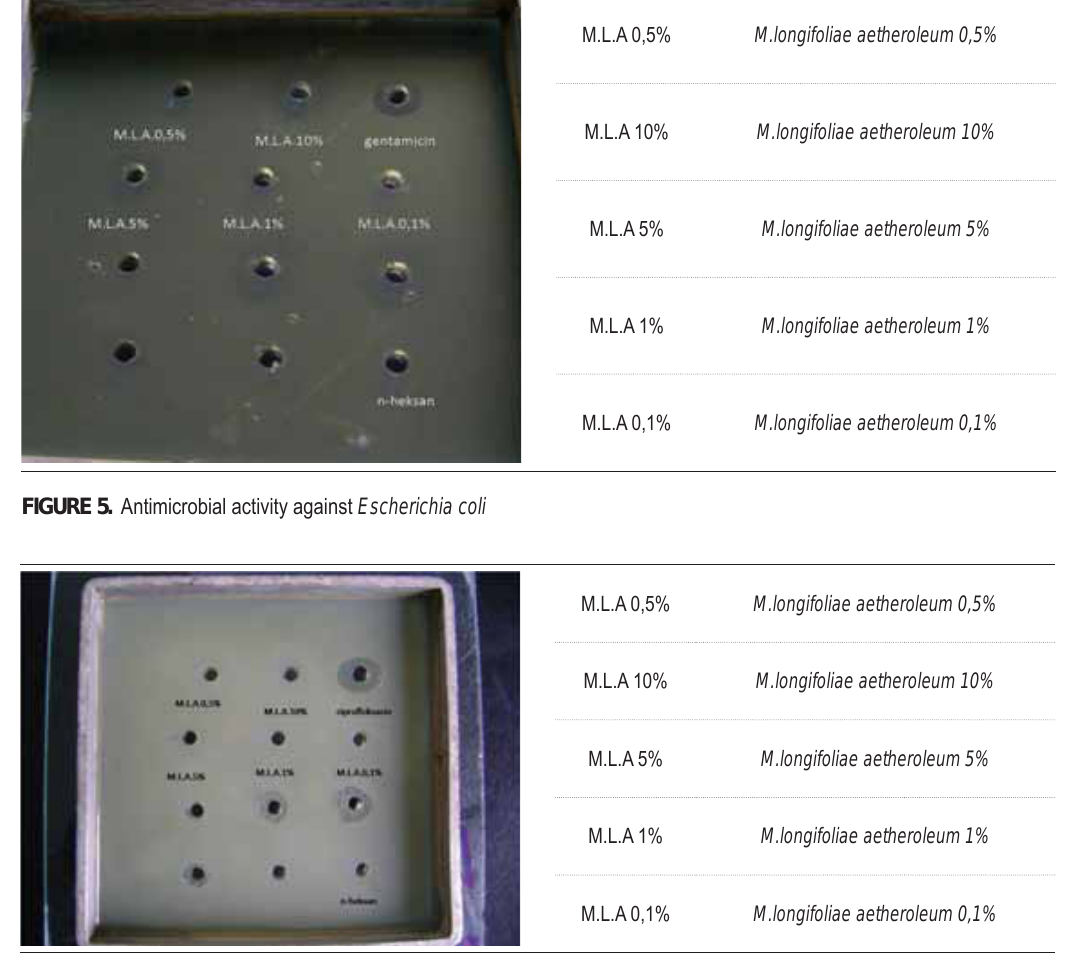
FIGURE 6. Antimicrobial activity against Pseudomonas